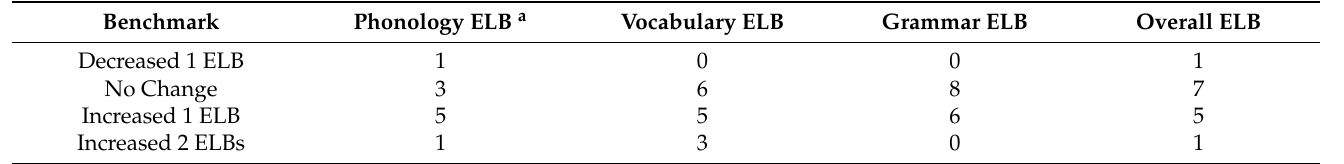
Table 6. Longitudinal Changes in Expressive Language Benchmarks ( n =